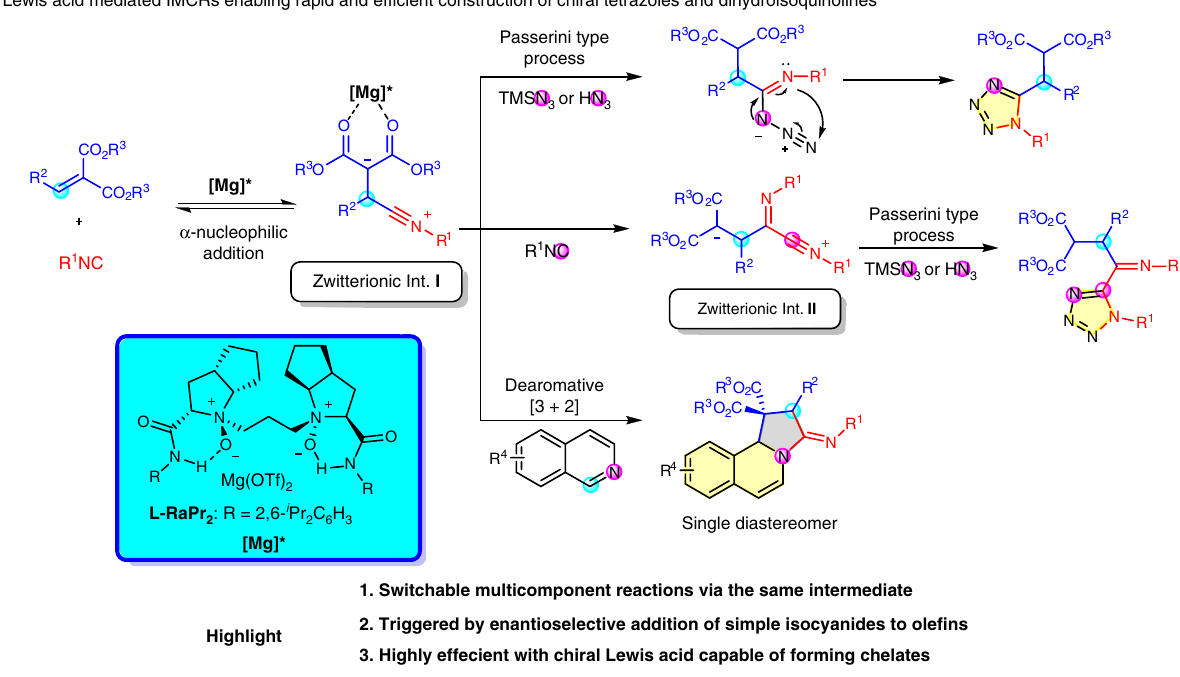
Fig. 1 Representative active substances and our strategies based on IMCRs for their construction. a Active substances with tetrazole and hydroisoquinoline motifs. b Our strategies to asymmetric synthesis of tetrazole and dihydroisoquinoline derivatives by